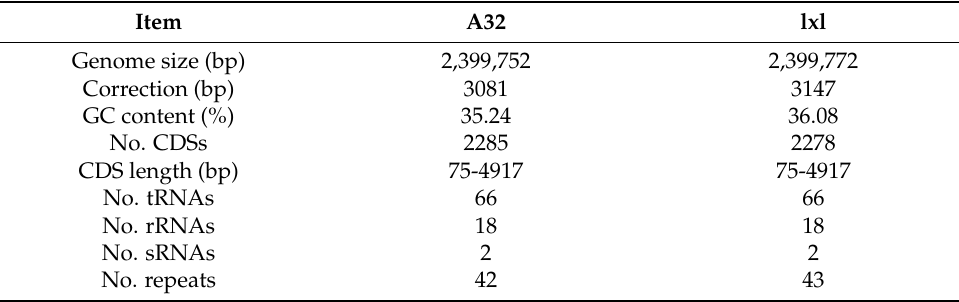
Table 1. Genome characteristics of L. lactis A32 and